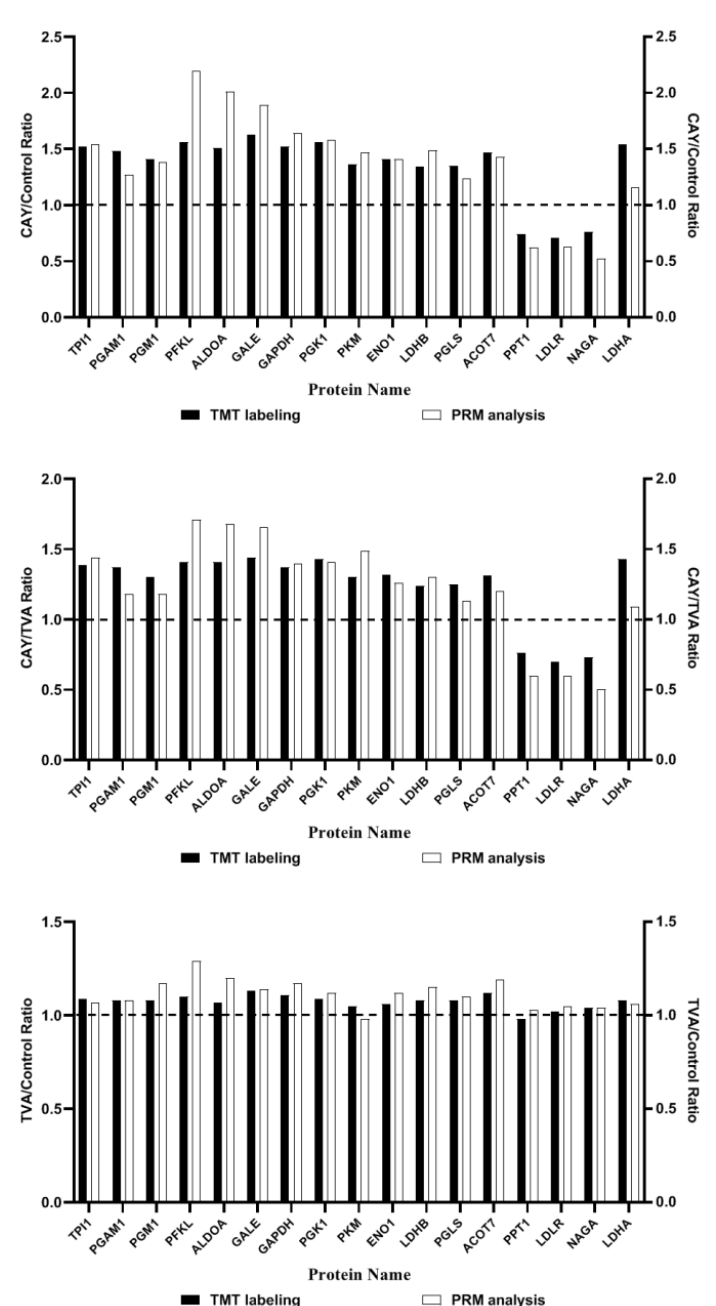
Figure 7. Tandem mass tag labeling and parallel reaction monitoring analysis among the differentially expressed proteins found in MAC-T cells under different incubation conditions. CAY group (SCD1-inhibited MAC-T cells model): incubated with 50 µ M TVA for 2.5 h after the treatment of CAY10566 at concentrations of 10 nM for 12 h, TVA group: only incubated with 50 µ M TVA for 2.5 h, and control group: without CAY,